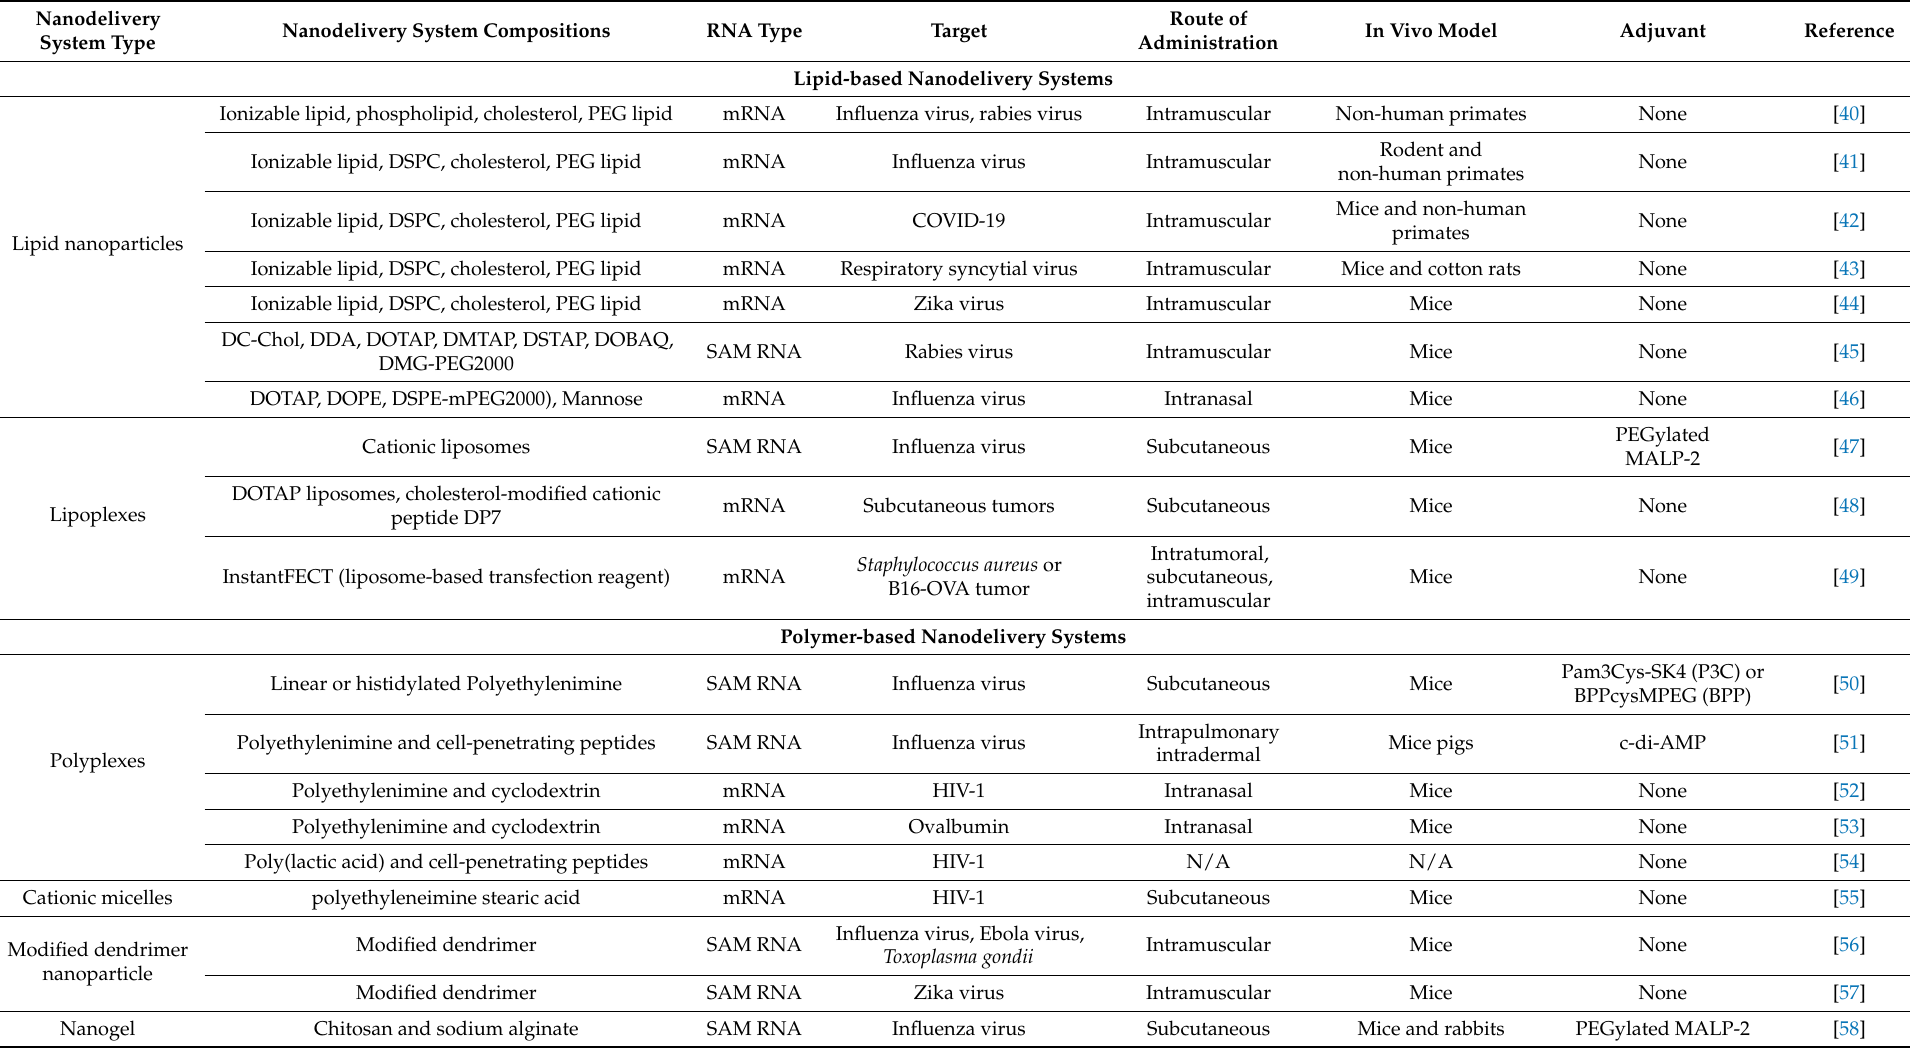
Table 2. Examples of recent nanodelivery systems for mRNA-based